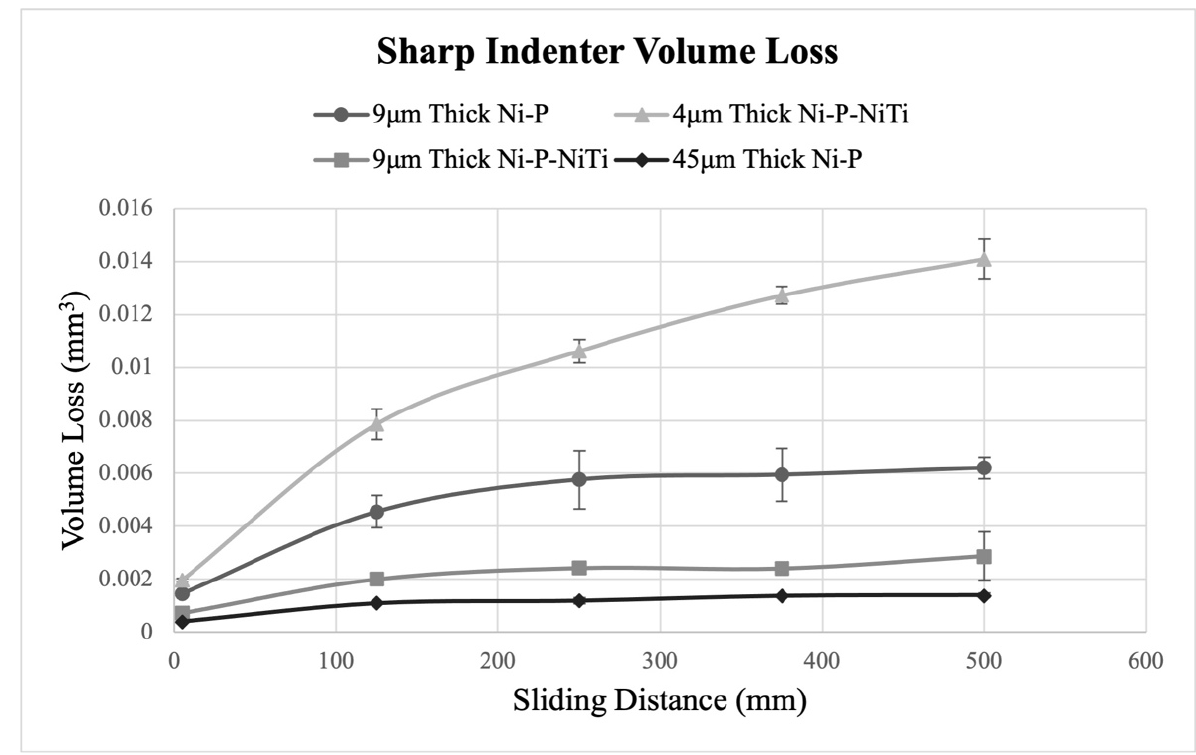
Figure 20. Volume Loss from the Sharp Indenter.